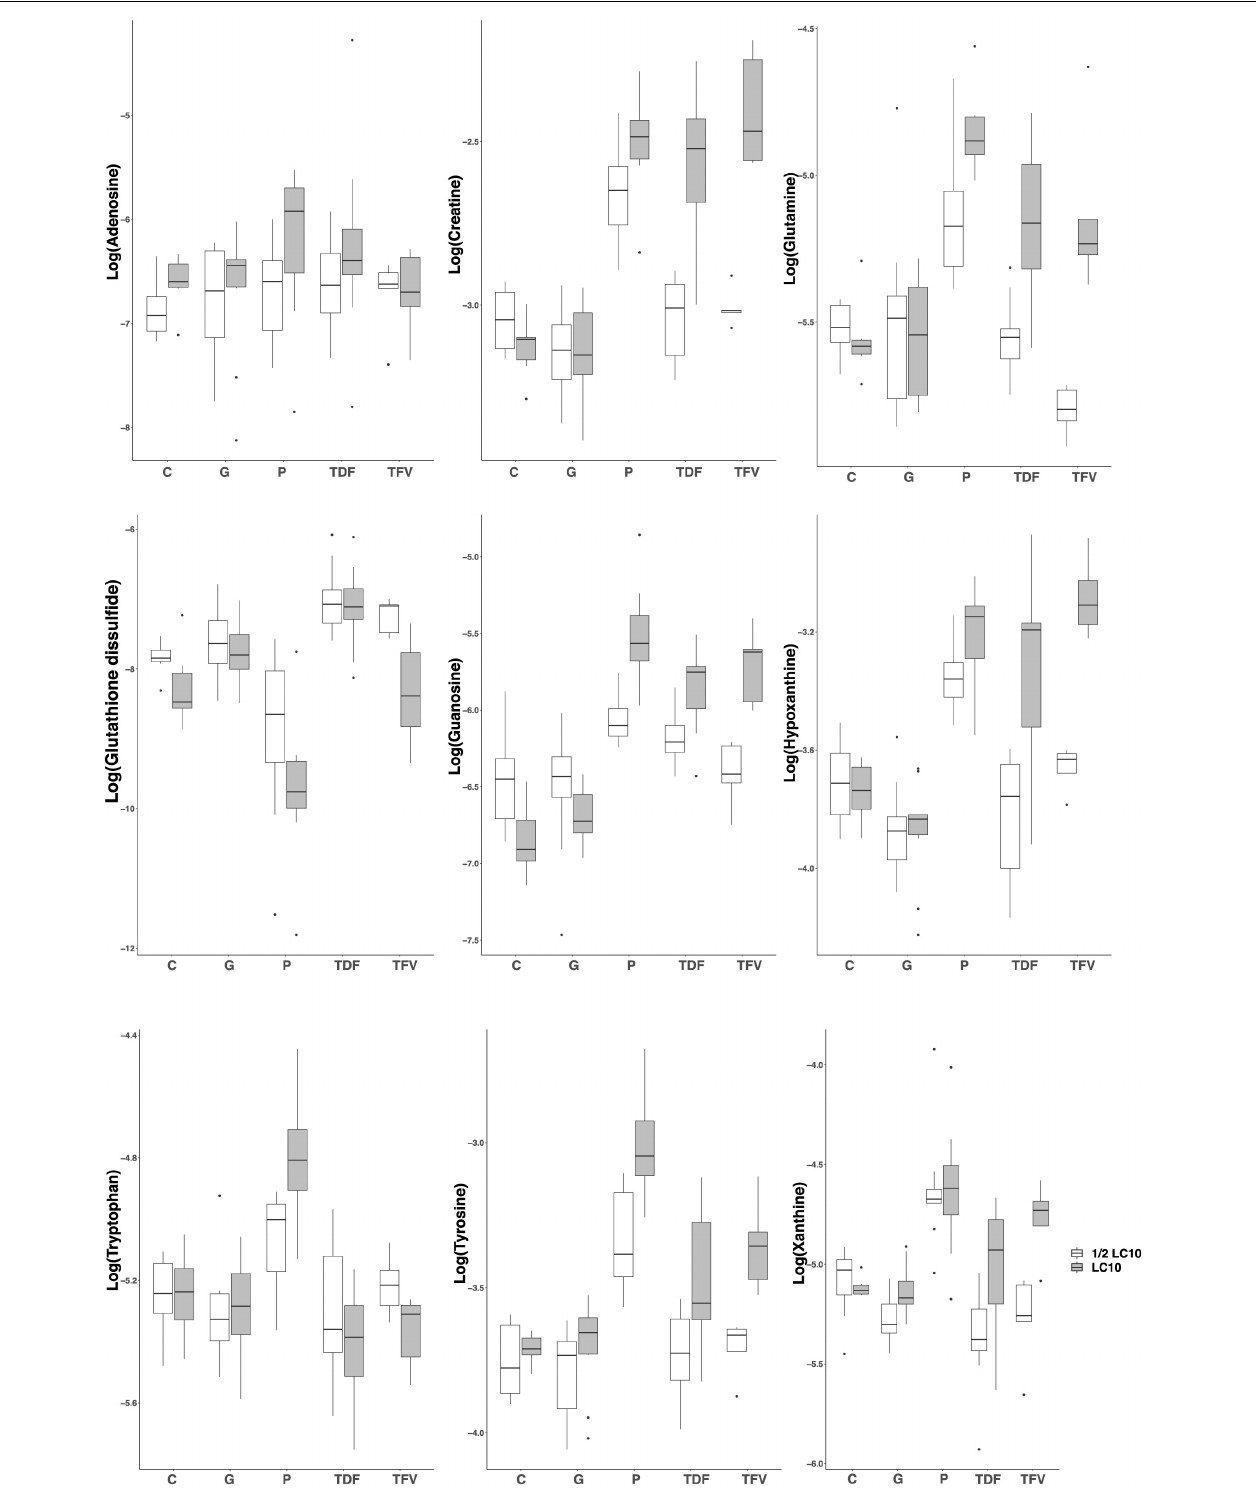
FIGURE 3 | Boxplots of the identified metabolites after PLS-DA modeling. Creatine, glutamine, guanosine, hypoxanthine and tyrosine were associated with the renal tubular toxicity of paracetamol, TDF and TFV. Adenosine and tryptophan were associated with the renal tubular toxicity of paracetamol. Xanthine and glutathione disulfide were associated with the renal tubular toxicity of TFV. LC10, lethal concentration for 10% of zebrafish larvae; C, control, G, gentamicin; P, paracetamol; TDF, tenofovir disoproxil fumarate; TFV, tenofovir.